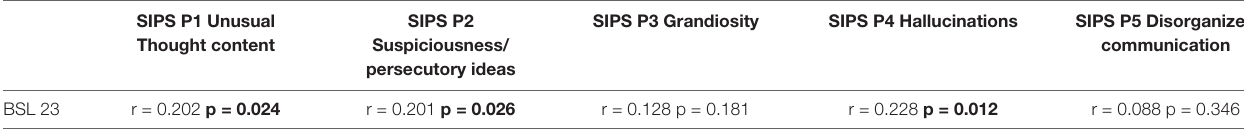
TABle 2 | Correlation (Kendall tau b) between borderline symptom checklist (BSL 23) and Structured Interview for Prodromal Symptoms (SIPS) positive